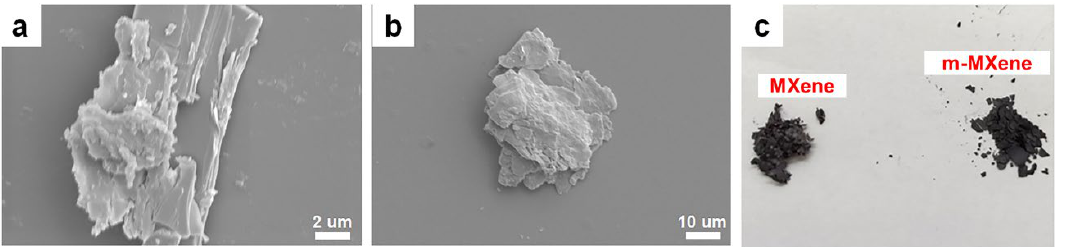
Figure 1. ( a ) SEM image of MXene; ( b ) SEM image of m-MXene; ( c ) Optical image of MXene and m-MXene.